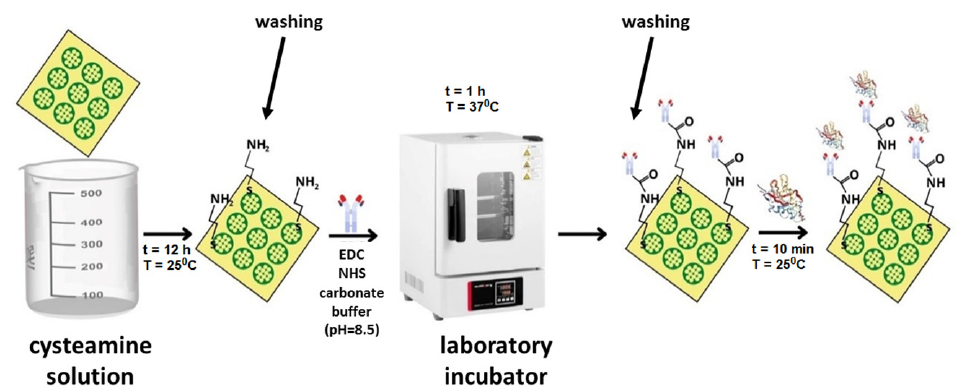
Figure 1. Scheme of the sensor preparation procedure.